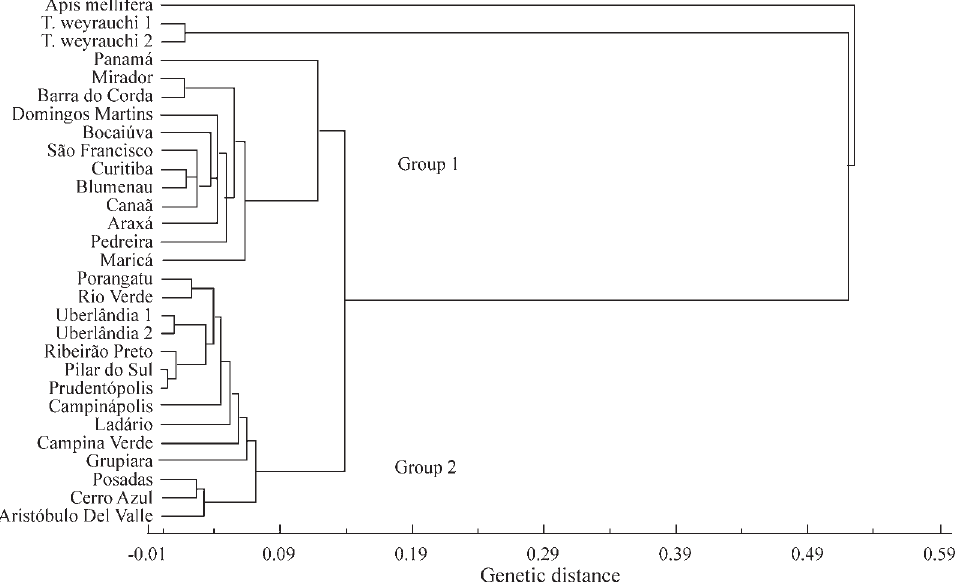
Figure 1 - Genetic distance based on percentage disagreement of 218 RAPD markers obtained from 18 random primers grouped by the unweighted pair group method with averages (UPGMA) for 29 genotypes (26 T. angustula, two T. weyrauchi and one A. mellifera)